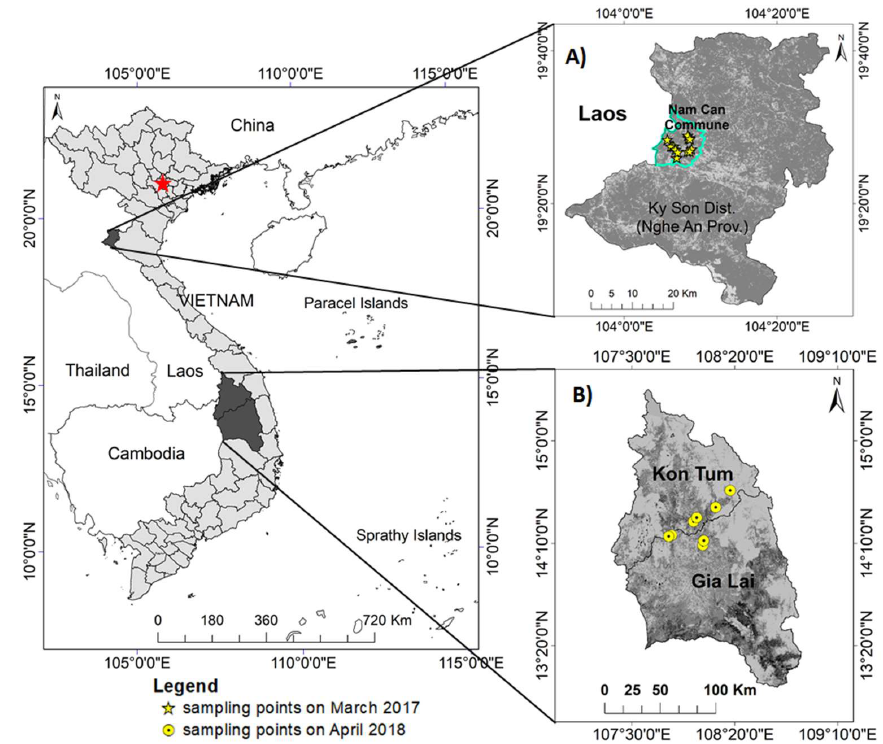
Figure 1. Locations of the soil sampling sites in Vietnam: ( A ) Locations of the 13 sampling points in Nam Can commune, Ky Son district, Nghe An Province; ( B ) locations of eight sampling points in the Kon Tum and Gia Lai Provinces, the northern part of the Central Highlands of Vietnam.